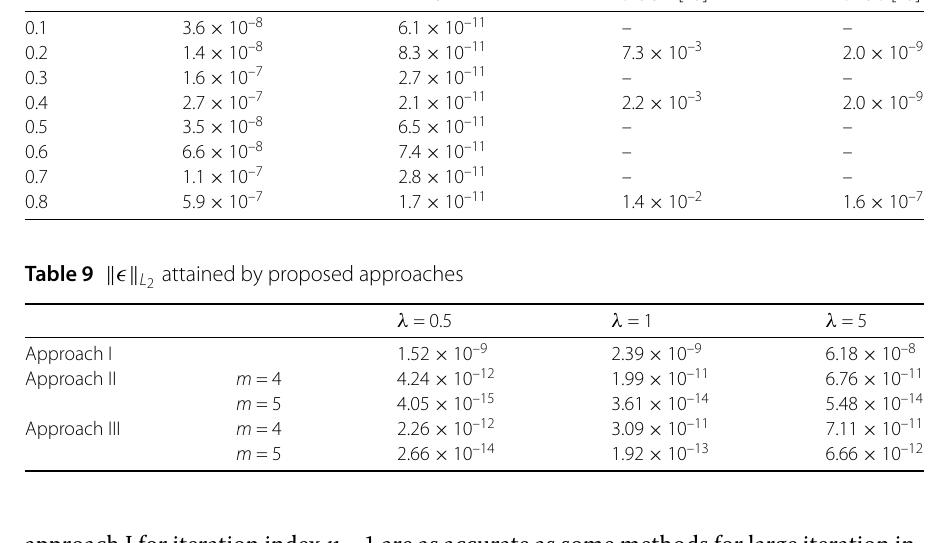
Table 8 Comparison of absolute errors of approximated solutions utilizing approach III for λ = 5 x m = 4 m = 5 B-SCM [25] DESG [13] 0.1 0.3